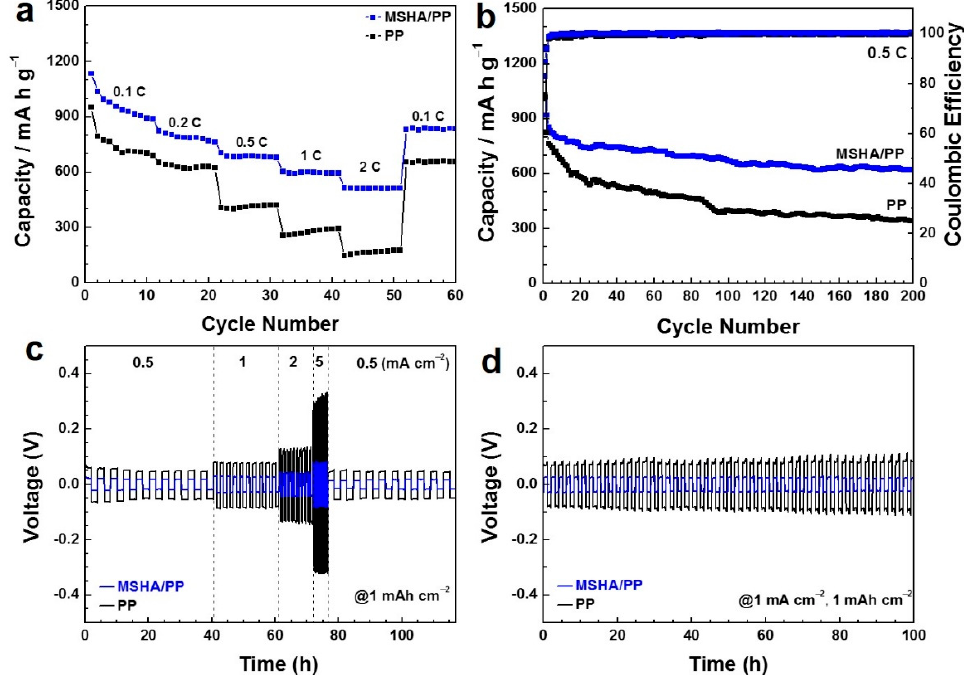
Figure 7. ( a ) Rate capability and ( b ) cycling stability of the cells configured with MSHA/PP and PP; ( c ) rate capability, and ( d ) cycling performance of Li||Li symmetric cells configured with MSHA/PP and PP.